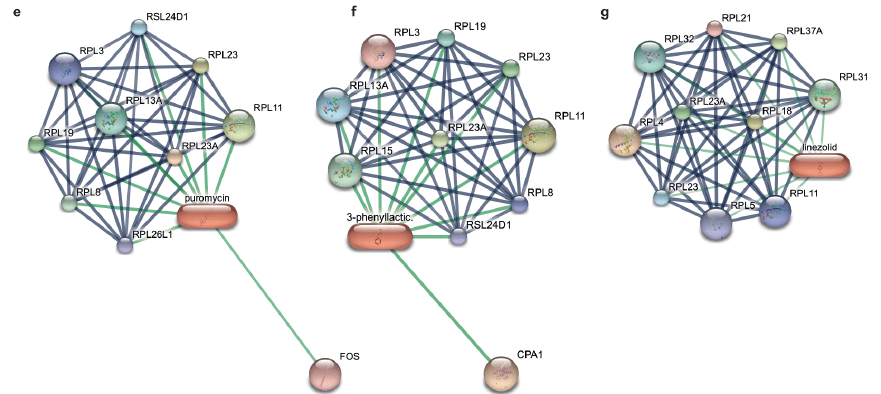
Figure 6. Gene-drug enrichment analysis of significant genes associated with the expression of DPP9 . ( a ) Volcano plot of the gene-drug enrichment results from significant genes associated with DPP9 in the colon and ( b ) in the jejunum using the DrugBank database. Significant drugs in bold (Spearman’s p -value < 0.05, FDR < 0.1). ( c ) Barplot of gene-drug enrichment results from significant genes associated with DPP9 in the colon and ( d ) in the jejunum using the STITCH database. Significant drugs in bold (Spearman’s p -value < 0.05, FDR < 0.1). ( e – g ) Protein-drug interaction networks of puromycin, 3-phenyllactic acid and linezolid, respectively.